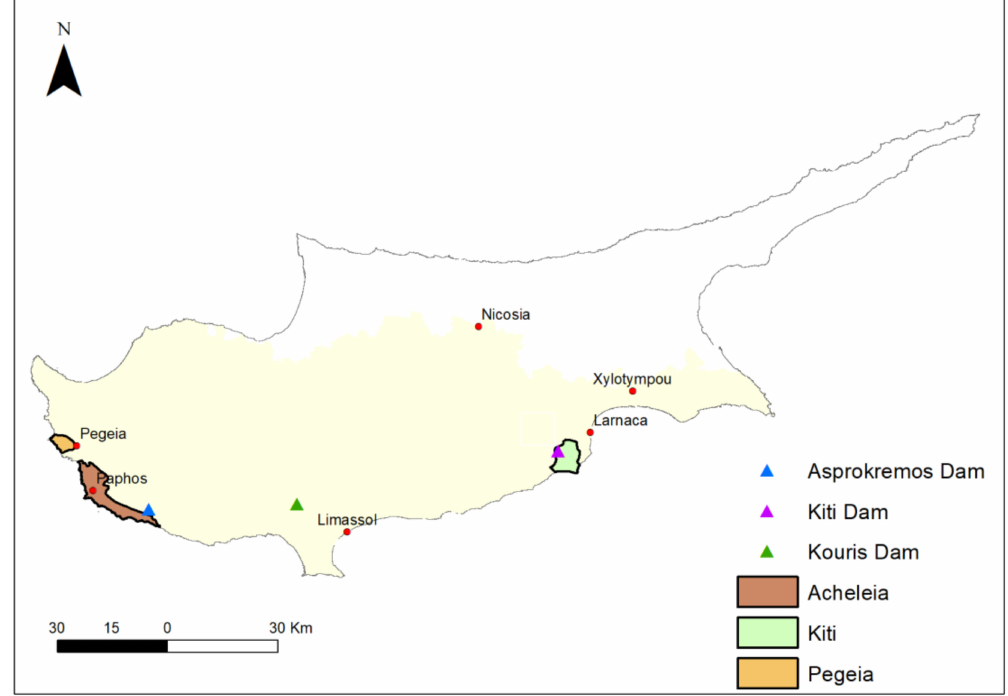
Figure 1. Aquifers of interest and SPEI implementation